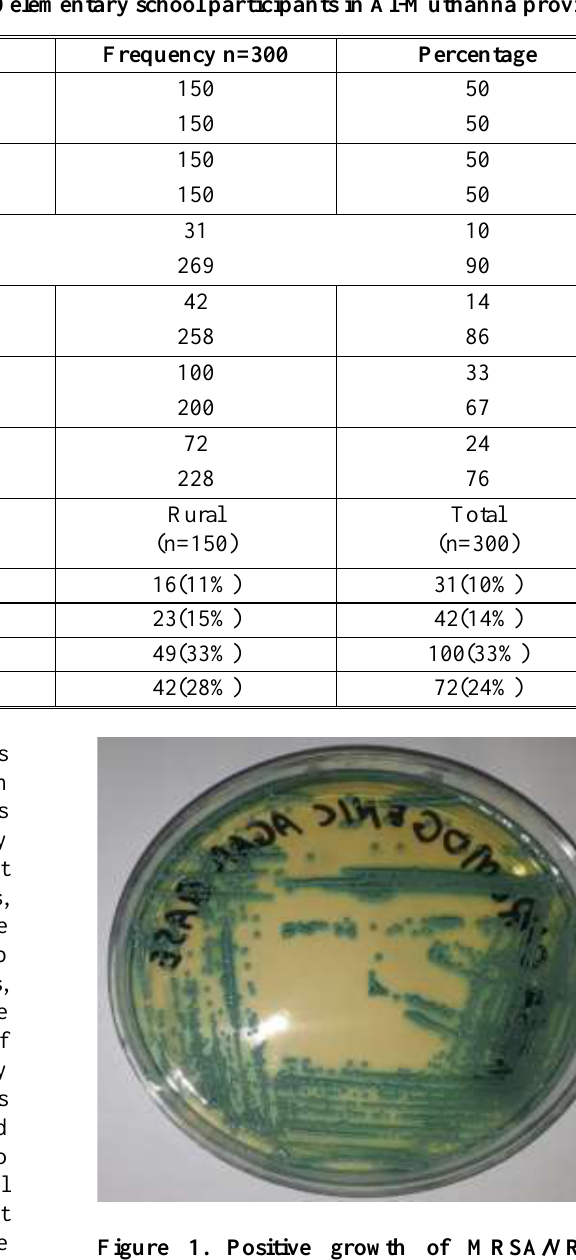
Table 1.Sociodemographic characteristics of 300 elementary school participants in Al-Muthanna province